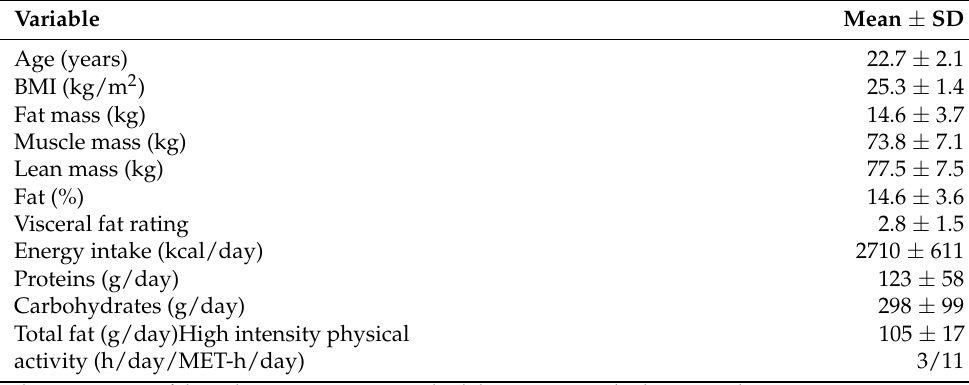
Table 2. Basic characteristics of professional handball players who participated in the dietary intervention (pilot)